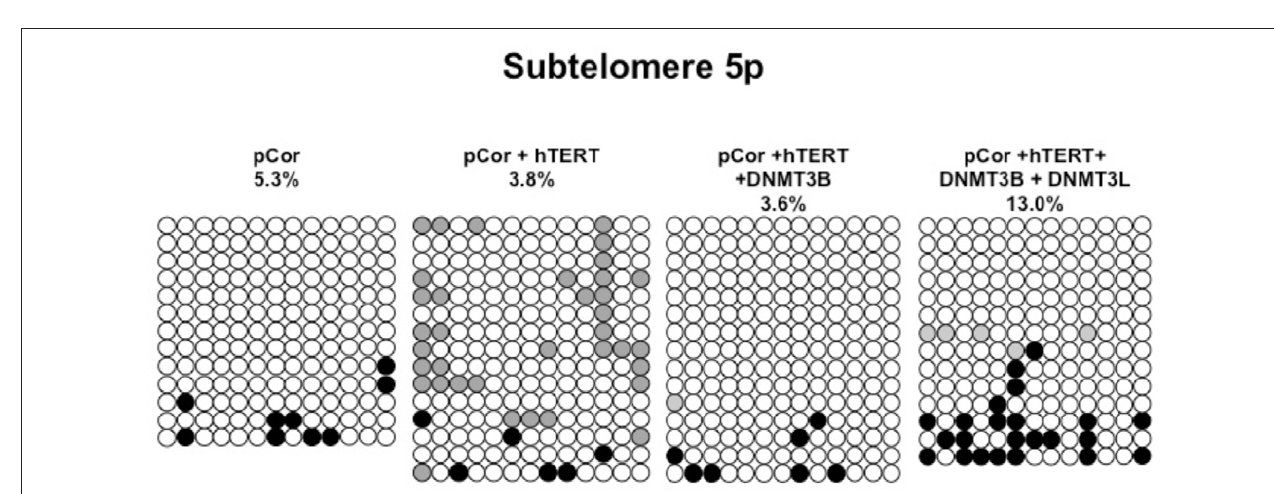
dinucleotides and black circles represent methylated CpG dinucleotides. Gray circles represent CpG sites that were converted to CpA or TpA, as occasionally can be observed. Each row is derived from an individual subclone. Percent of CpG methylation appears below the cell type.